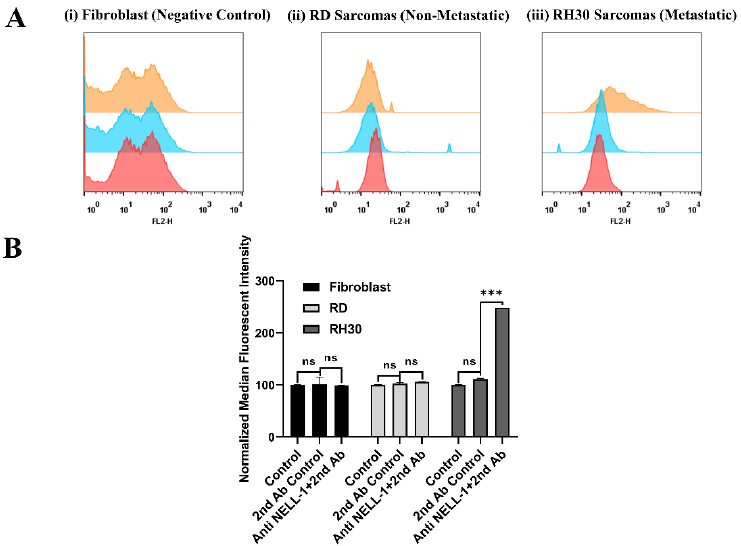
Figure 1. Validation of NELL1 on cell surface measured by flow cytometry. ( A ) Representative flow cytometry histogram result for fibroblast, RD, and RH30 sarcoma cells. Cells were incubated with either PBS (red), Cy3-labeled anti-rabbit secondary antibody only (blue), or anti-NELL1 primary antibody and Cy3-labeled anti-rabbit secondary antibody (orange). ( B ) Results from the normalized median fluorescence intensity of flow cytometry for fibroblast, RD, and RH30 sarcoma cells. Cells were incubated with different incubation in the PBS (control), Cy3-labeled anti-rabbit secondary antibody only (2nd Ab control), or anti-NELL1 primary antibody and Cy3-labelled anti-rabbit sec- ondary antibody (Anti NELL1 and 2nd Ab). Data are presented as mean ± SD for each individual cell line ( n = 3 independent experiments of triplicates). Significance was tested using a two tailed t- test compared to the untreated cells for each cell line (*** p ≤ 0.005, ns = not significant). As the NELL1 was shown to be localized on the outer cell membrane of RH30 (Figure 1), the expression level was then confirmed and compared by Western blotting (Figure 2). β -Actin was used as a housekeeping gene since it remains at a steady level in most kinds of mammalian cells (Figure 2A, S3) [22]. Similar to the observed FACS results, RH30 sar- coma cells showed a nearly threefold higher expression level than RD cells (Figure 2B). In addition, fibroblasts were monitored as they represented normal cells in the body, which might lead to false targeting if they had a high NELL1 expression [23]. U-87MG was cho- sen as a further negative control as it has been shown to have very low NELL1 expression in previous studies [24]. Based on the normalized quantification blotting signal, both of the negative controls (fibroblast and U-87MG) showed a significantly lower level of NELL1 expression compared with RH30 cells (Figures S1 and S4; Tables S1 and S2).